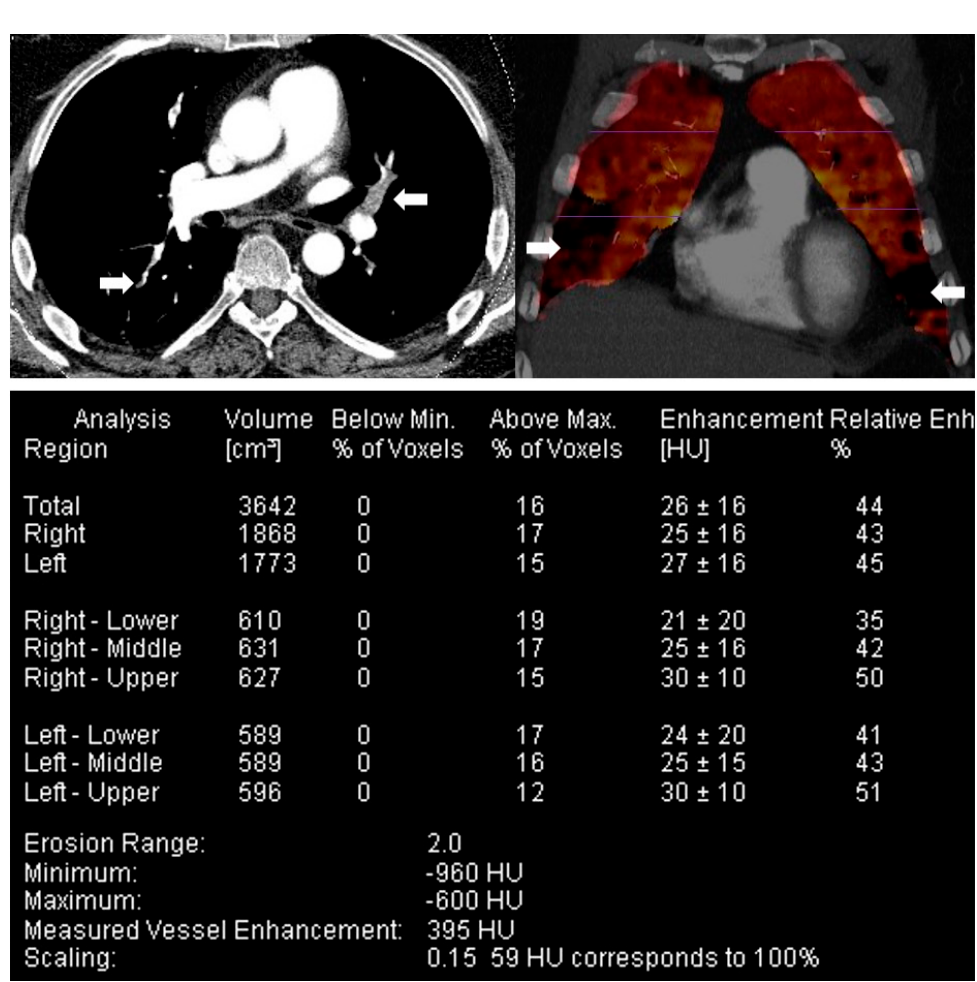
Figure 6. Dual-energy CT in acute pulmonary embolism (PE).Top row: Panel A: Axial CT pulmonary angiography with multiple acute PE (block arrows). Panel B: Corresponding coronal colour-coded overlay of a pulmonary perfusion map with multifocal wedge-shaped perfusion defects (block arrows). Bottom row: The numerical information corresponding to the perfused blood volume shows the lung volume (cm 3 ) and iodine perfusion (enhancement in Hounsfield Unit, HU). The right and left lobes of the lung are visualised and evaluated independently. Both lobes of the isolated lung are subdivided into upper, middle, and lower parts based on the volume of the segmented lobes. Image courtesy